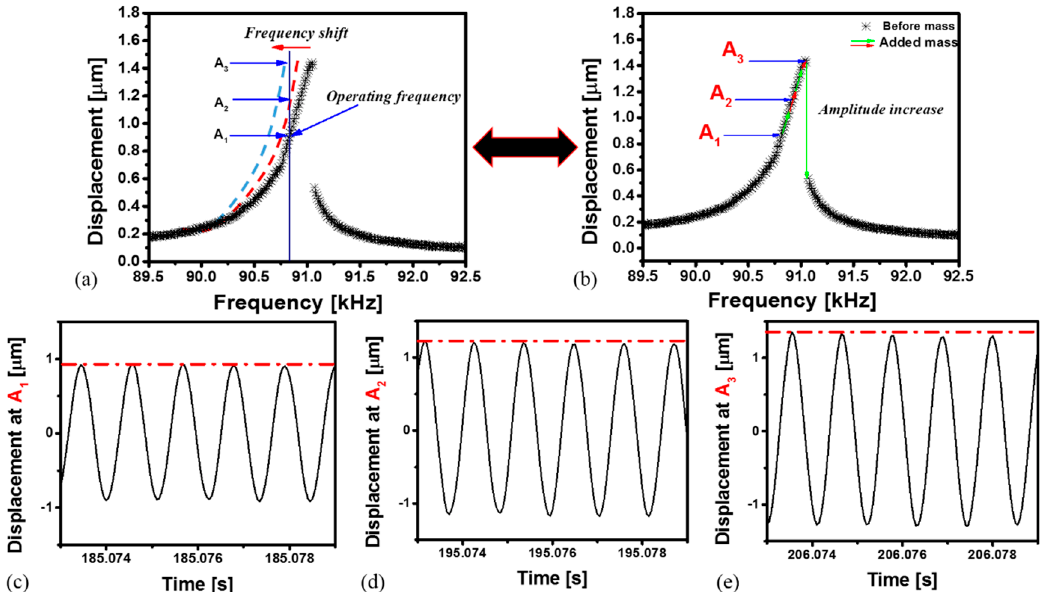
Figure 8. Mass quantification concept at different vapor exposure steps. ( a ) Frequency response curves before (experimental, black stars) and after vapor exposure (schematic, dashed). The vertical line indicates a fixed operating frequency of the resonator during vapor exposure. Clearly, the amplitude of the resonator increases with the absorption of vapor; ( b ) The same experiments in ( a ) can be viewed based on a single frequency-response curve before vapor exposure. Vapor absorption can be viewed as riding the upper branch of the frequency response curve; ( c – e ) Measured time history showing the displacement at ( c ) point A 1 ; ( d ) point A 2 and ( e ) point A 3 .